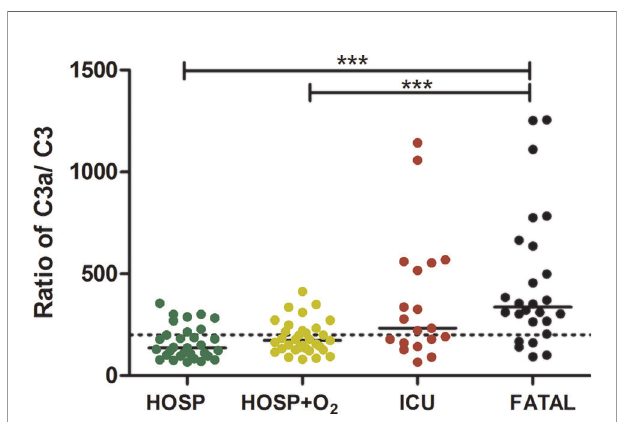
FIGURE 5 | Association of complement C3 overactivation and consumption, and peak severity of COVID-19. Ratios of complement anaphylatoxin C3a/C3 (Kruskal-Wallis test p < 0.0001, ***Dunn ’ s post test p < 0.001) are presented in patient groups strati fi ed according to peak severity. Cut-point (200) used in the survival analysis is indicated by horizontal, dashed line.